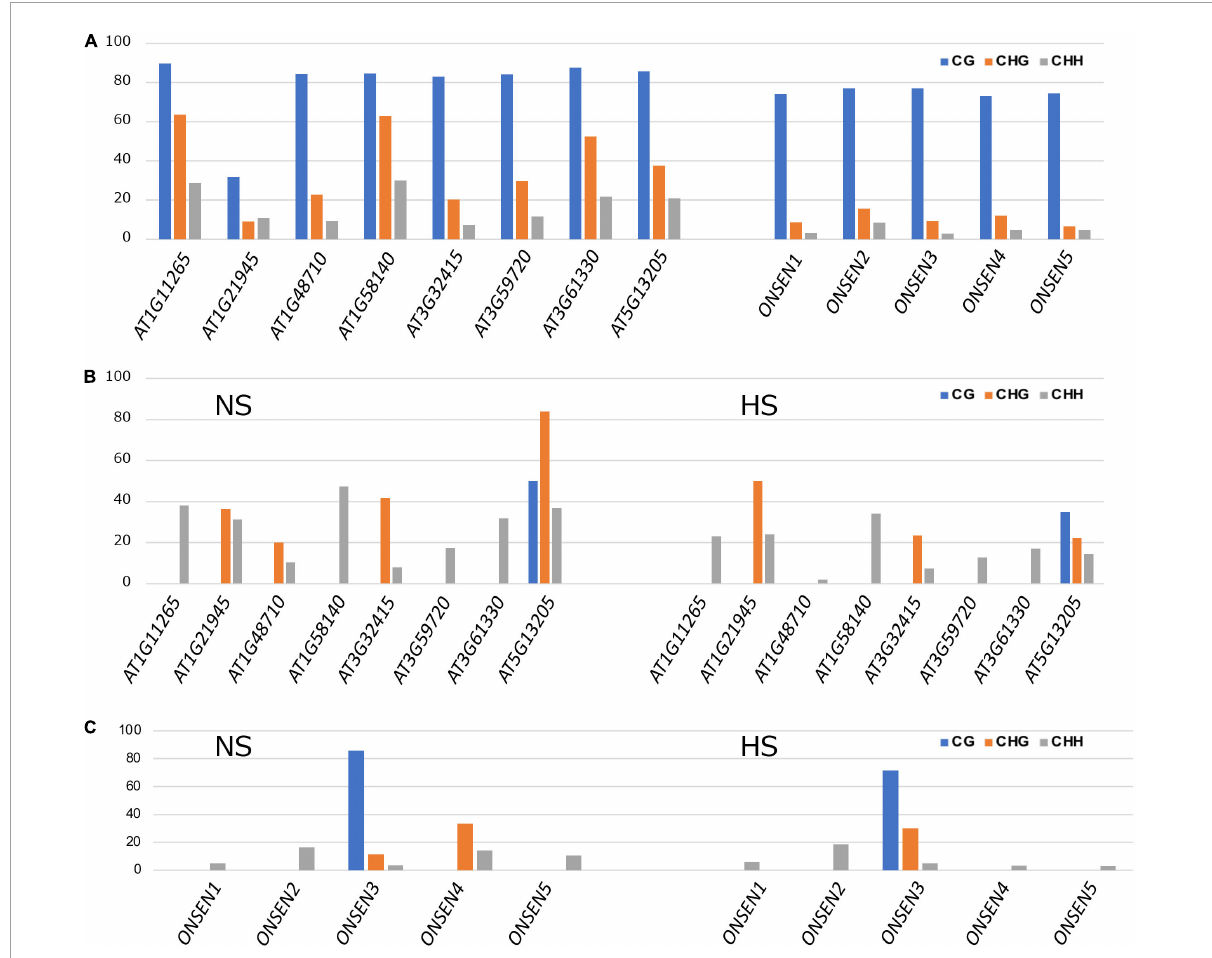
FIGURE4 ONSEN methylation. (A) DNA methylation levels of ONSEN elements under non-stressed control conditions. (B) ONSEN LTR methylation levels in non-stress (NS) and heat-stressed (HS) Col-0. (C) ONSEN LTR methylation levels of individual in NS and HS